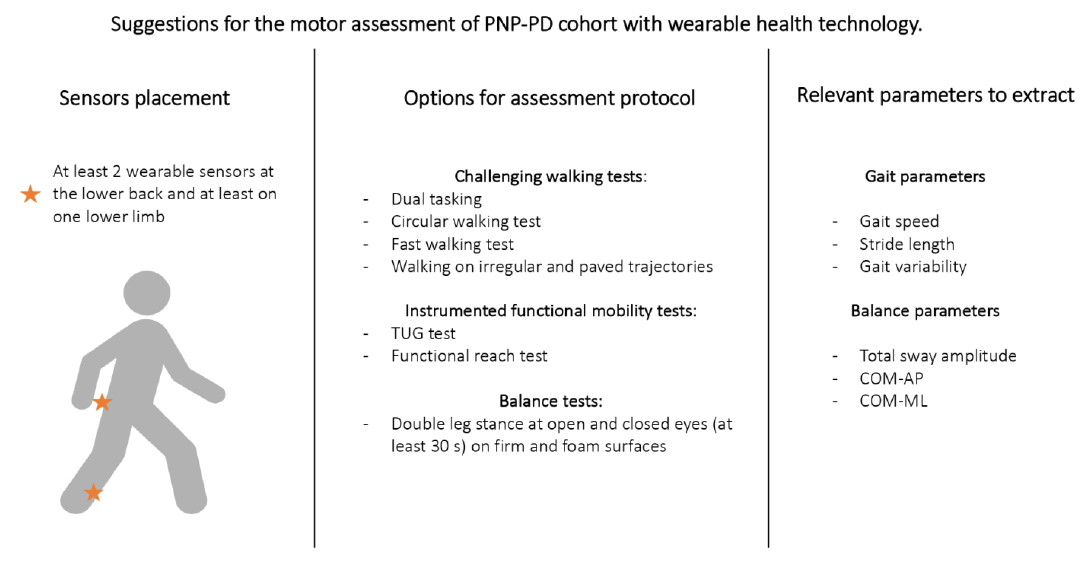
Figure 4. Suggestions for the motor assessment of PNP-PD cohort with wearable health technology.